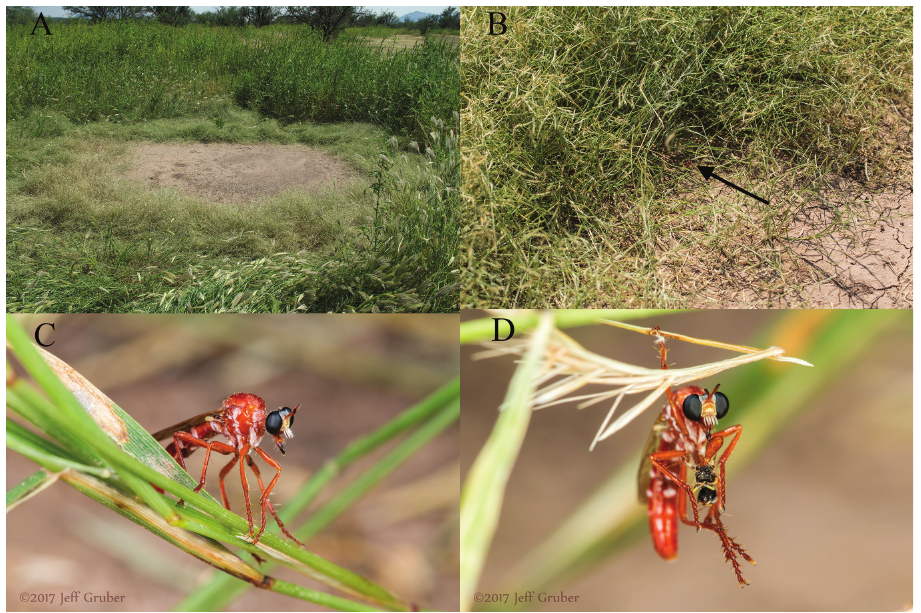
Figure 27. Saropogon pyrodes sp. nov. in natural habitat at ~ 0.7 km ENE of Amado in southern Arizona on September 5, 2017 A habitat overview B habitat detail with S. pyrodes included (arrow) C close-up of male perching D close-up of male consuming a bee (Hymenoptera: Apidae). Photographs by Jeff